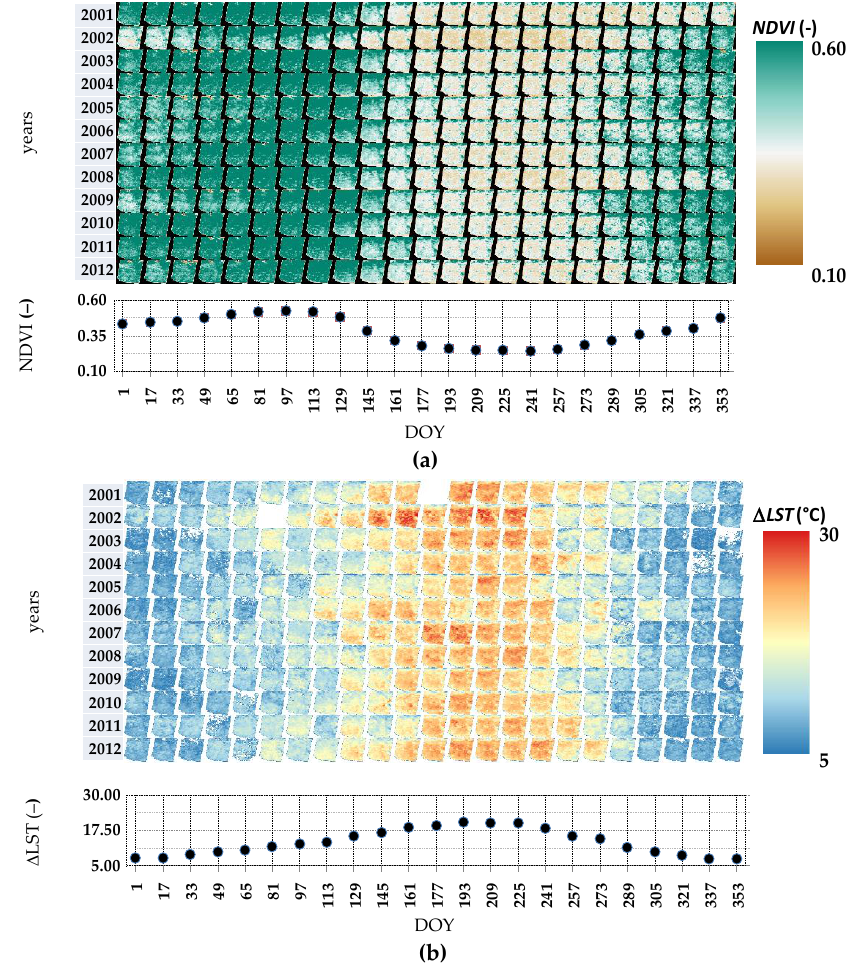
Figure 7. Time-domain mosaics of both ( a ) NDVI and ( b ) ∆ LST . DOYs and years are reported on the x -axis and y -axis, respectively. Average values (over space and multi-years) of NDVI and ∆ LST are plotted for each DOY.